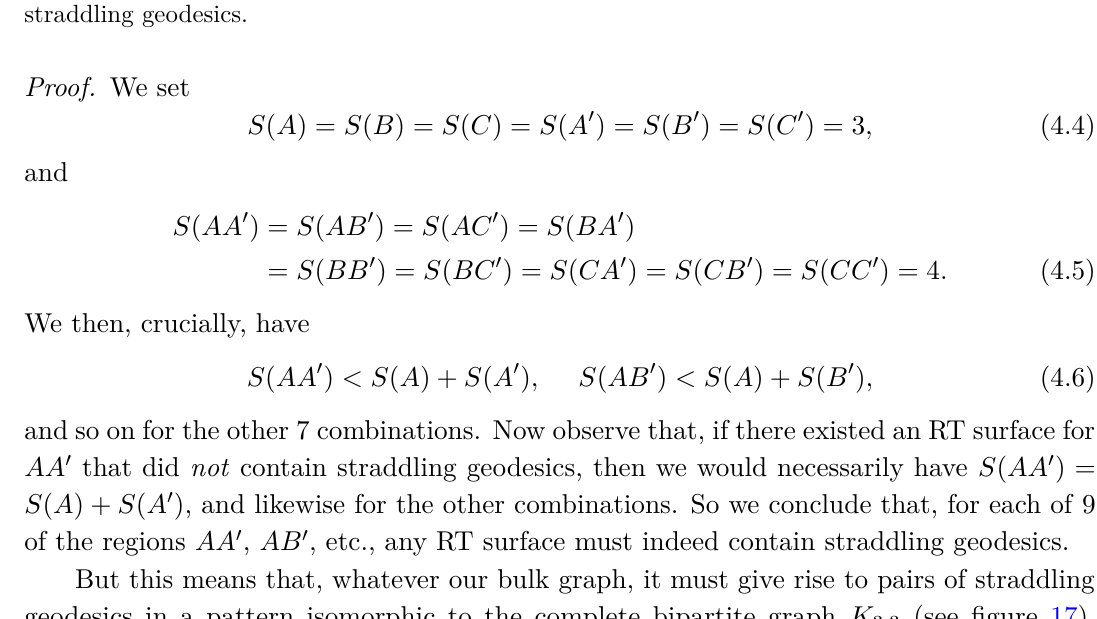
Figure 17 . The non-planar graph K 3 , 3 embedded into a two-boundary geometry, via 9 pairs of straddling